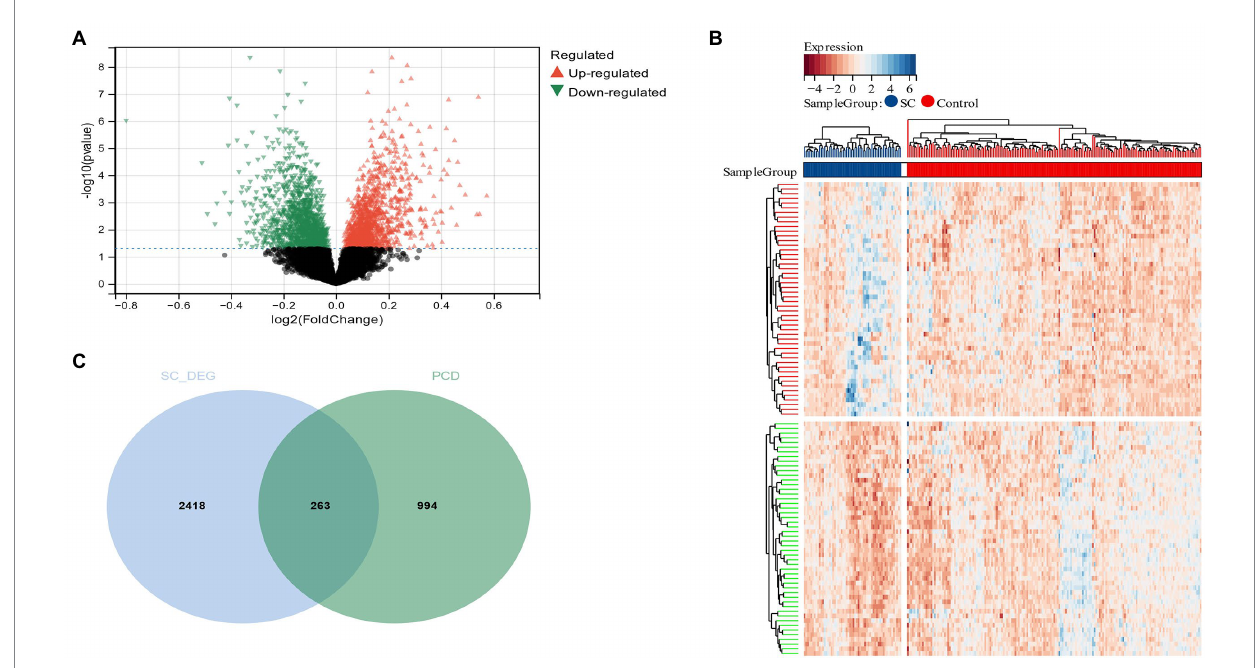
FIGURE 2 (A) The volcano plot shows all DEGs of schizophrenia, of which red and green triangles refer to significant DEGs; (B) Based on the SC dataset, the heatmap displays the top 50 DEGs that have been upregulated or downregulated. Rows represent intersections of genes, while columns represent SC cases or controls. The blue and red colors represent genes whose expression has been upregulated or downregulated; (C) Cross-screening of schizophrenia DEG and PCD-related genes yielded relevant candidate